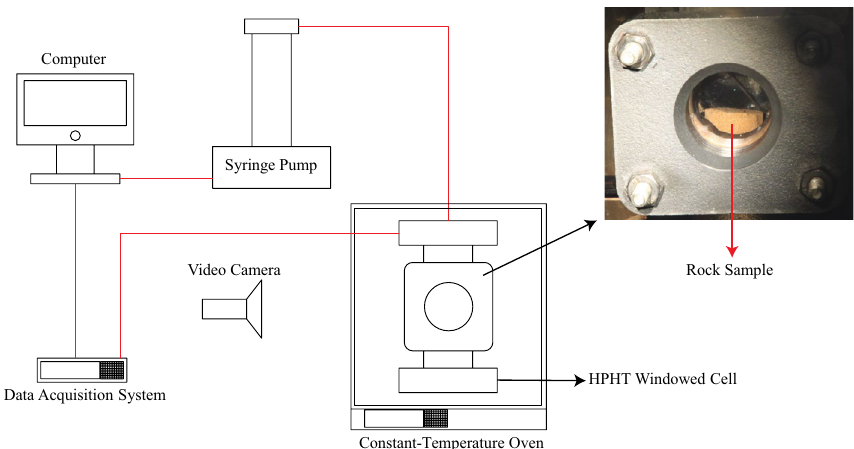
Figure 2. A schematic of the experimental system utilized for solvent vaporization temperature measurement. The rock sample was immersed in glycerol which acted as a heating liquid. The thermocouple was also immersed in glycerol to measure its temperature